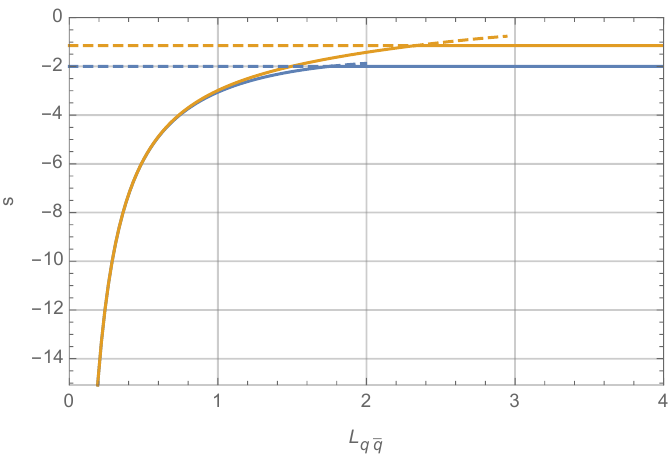
Figure 5 . The renormalized on-shell action for the fundamental string at (cid:11) = (cid:25)= 2 as a function of L q (cid:22) q . The di(cid:11)erent lines correspond to (cid:21) = (0 ; 0 : 9) from bottom to up. For both values of (cid:21) we show the two solutions discussed in the text above, the dominant and subdominant solutions are plotted with a solid and a dashed line,